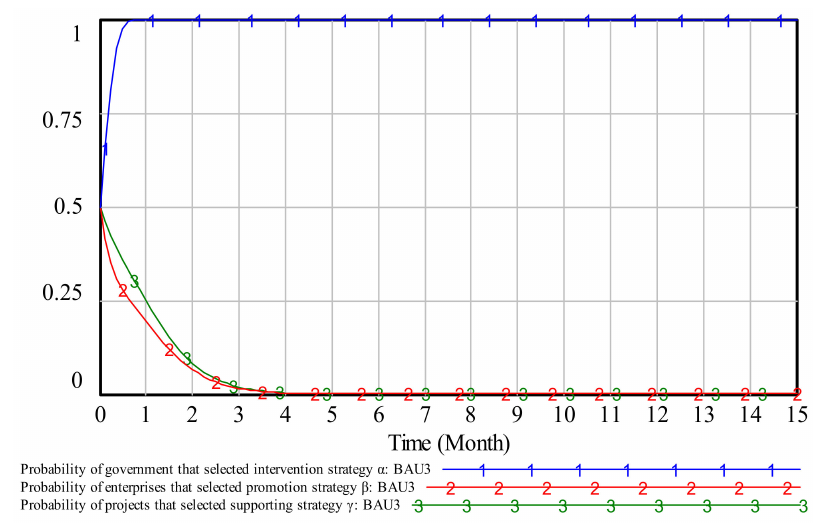
Figure 5. Stability test of the equilibrium point (1,0,0).